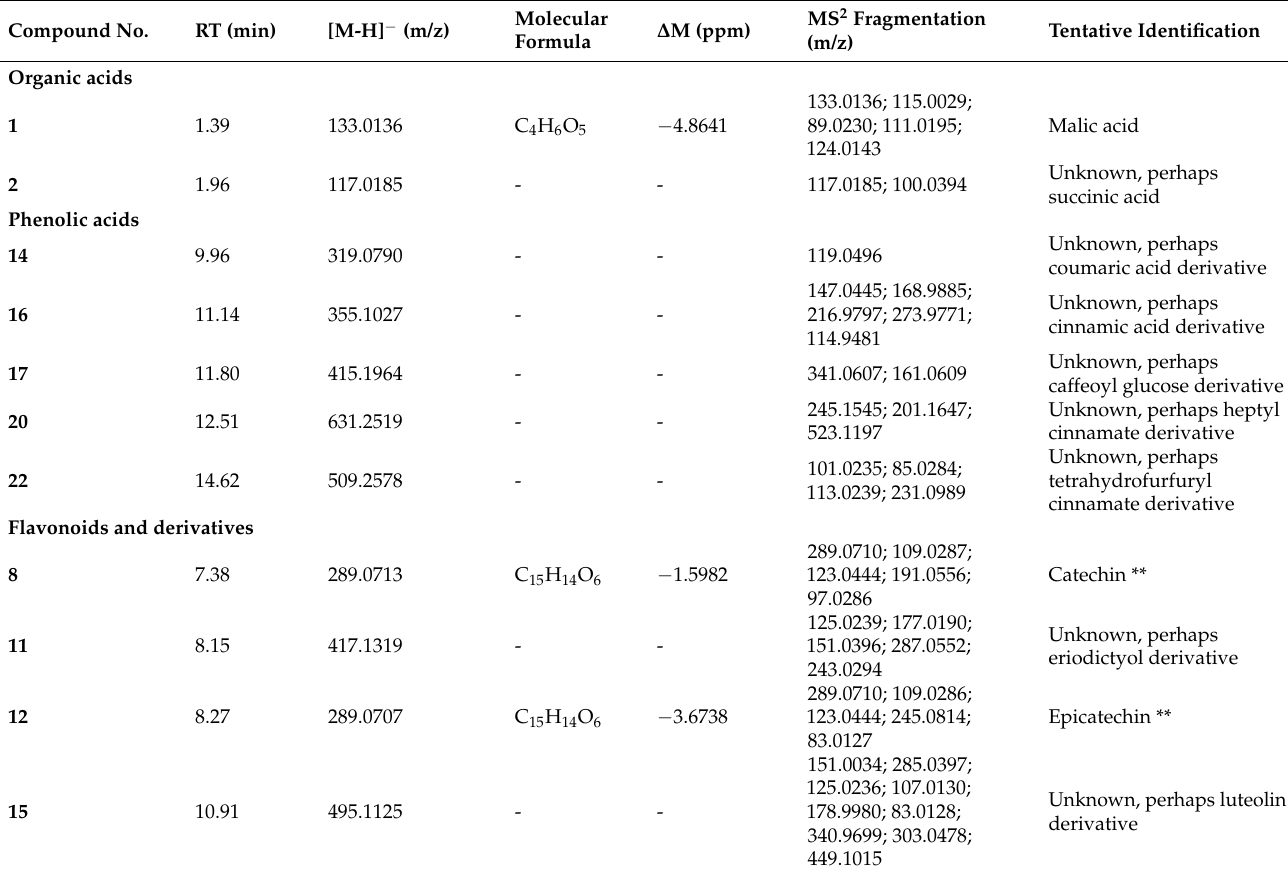
Table 5. Non-anthocyanin phenolic compounds (tentatively) identified in the aqueous extracts from Diploglottis bracteata